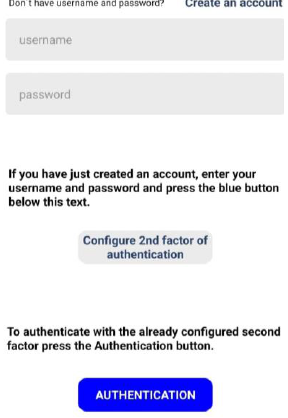
Figure 6. Login screen.